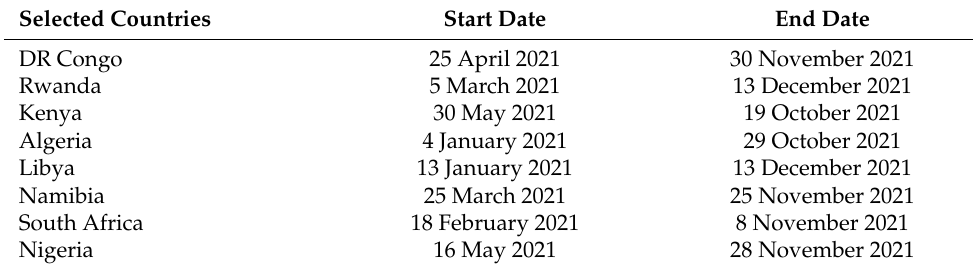
Table A1. Selected countries in each region with their start date and end date. Selected Countries